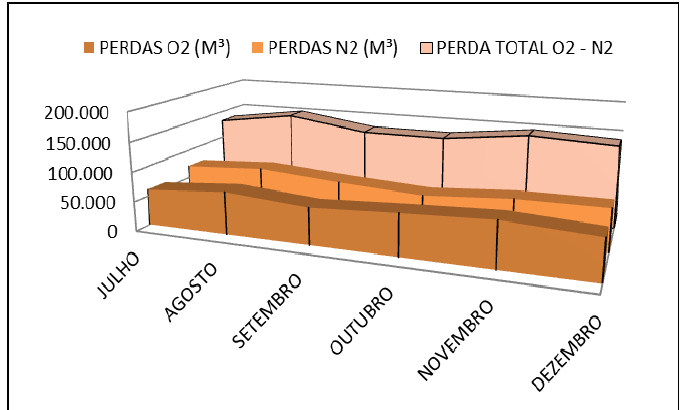
Figura 7. Perda mensal de O 2013.